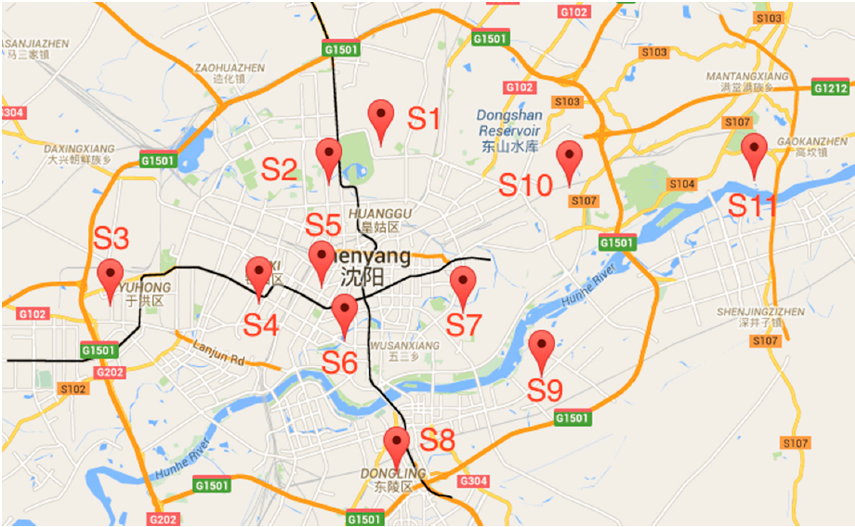
Figure 1. Monitoring station locations in Shenyang city (China).